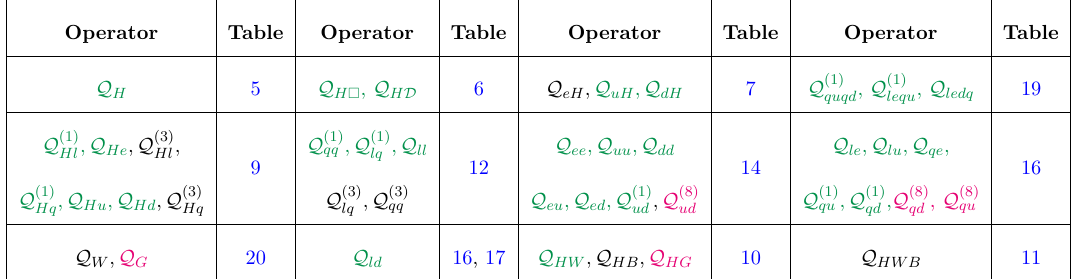
extension alone. Further extension by the ϕ ( 1 , 2 , 1 ) 2